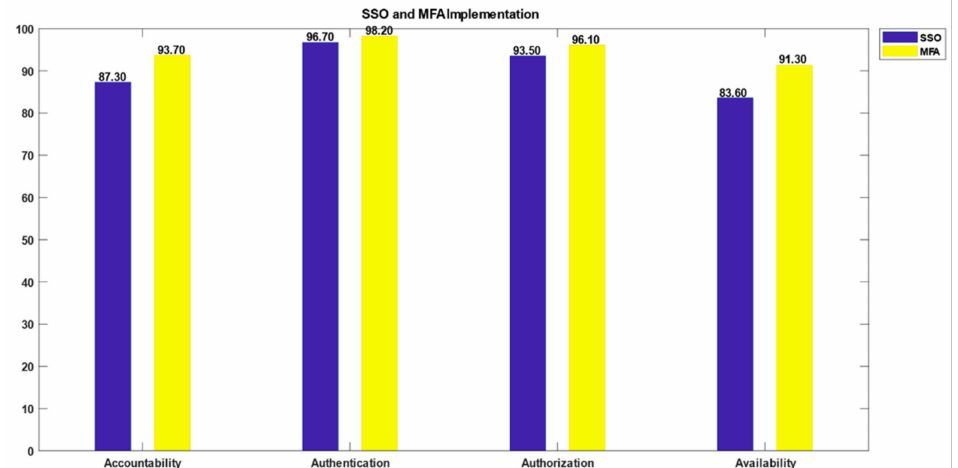
Figure 5. Authentication, authorization, accountability, and availability (AAAA) comparison of SSO and MFA